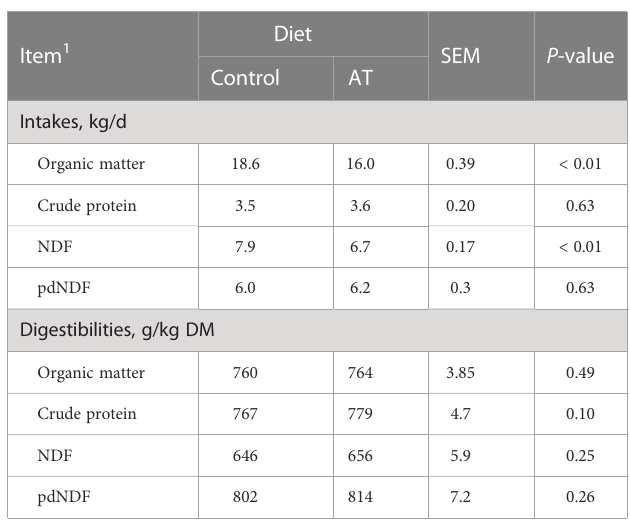
TABLE 6 Ruminal fermentation for cows fed a grass silage-based diet without (control) or with supplementation with Asparagopsis taxiformis (AT)